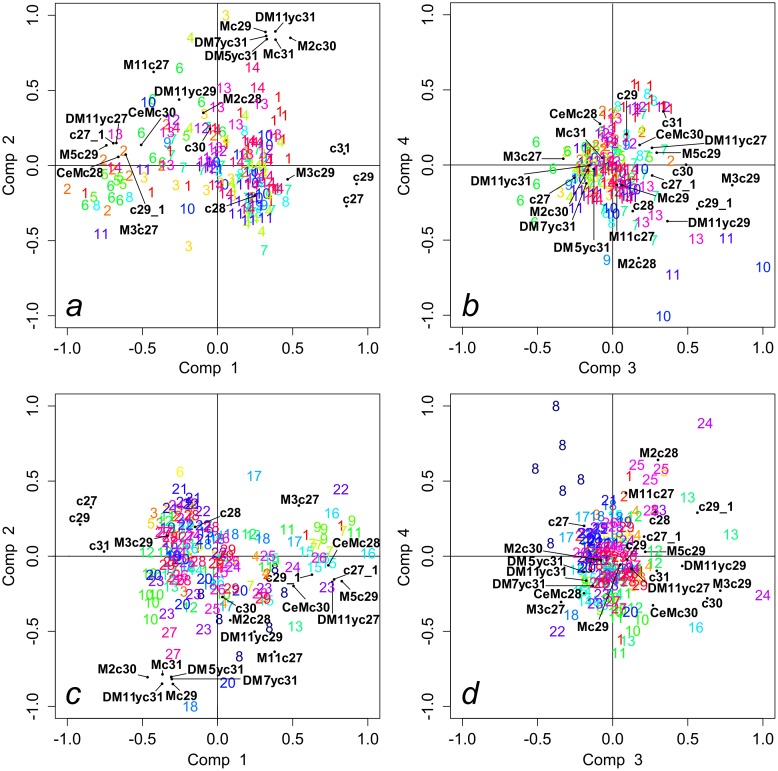
PLS-DA plots on chemical distances.Plots for genetic clusters (a, b) and nests (c,d) are described by the first two pairs of components (Comp). Scores were normalized between -1 and 1 and plotted in the same graph with the loadings of variables. Scores of individual ants of the same group are represented by the same number (14 genetic clusters and 29 nests). Loadings of variables are indicated by compound names (see Fig 2). According to biplot theory, proximity among cases (individuals) and variables (compounds) represents a tendency of individual ants to have a higher abundance of the studied compounds.